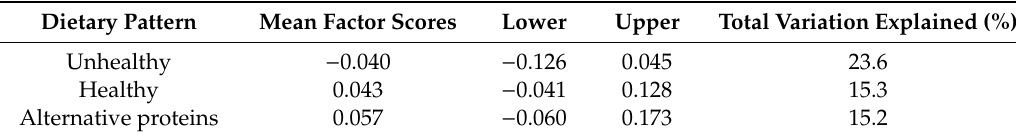
Table 3. Dietary patterns of adolescents in Malaysia.